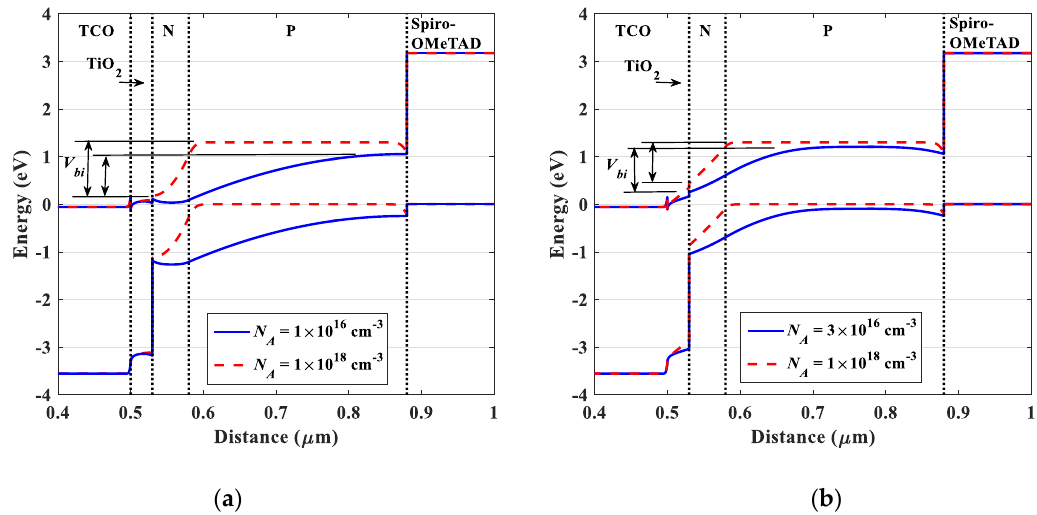
Figure 9. The energy band diagrams of the proposed structure at the dark condition for ( a ) N D in the n-side is maintained at 3 × 10 17 cm –3 , ( b ) fixed value of N D = 3 × 10 16 cm −3 .